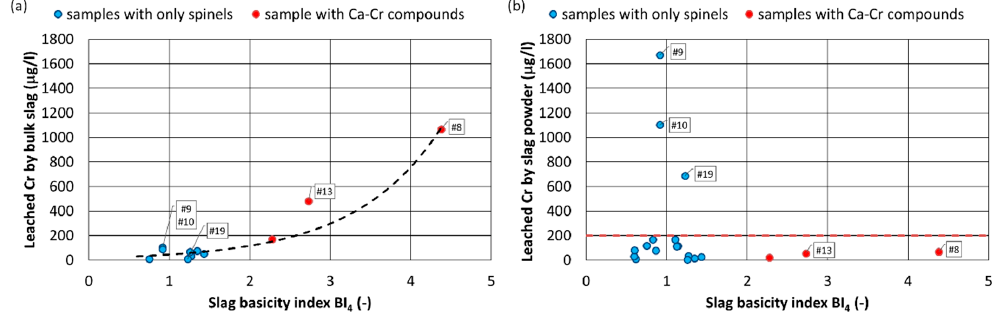
Figure 4. Effect of slag basicity on Cr leaching for ( a ) bulk slag and ( b ) slag powder. Marked samples represent remarkable behavior slag.